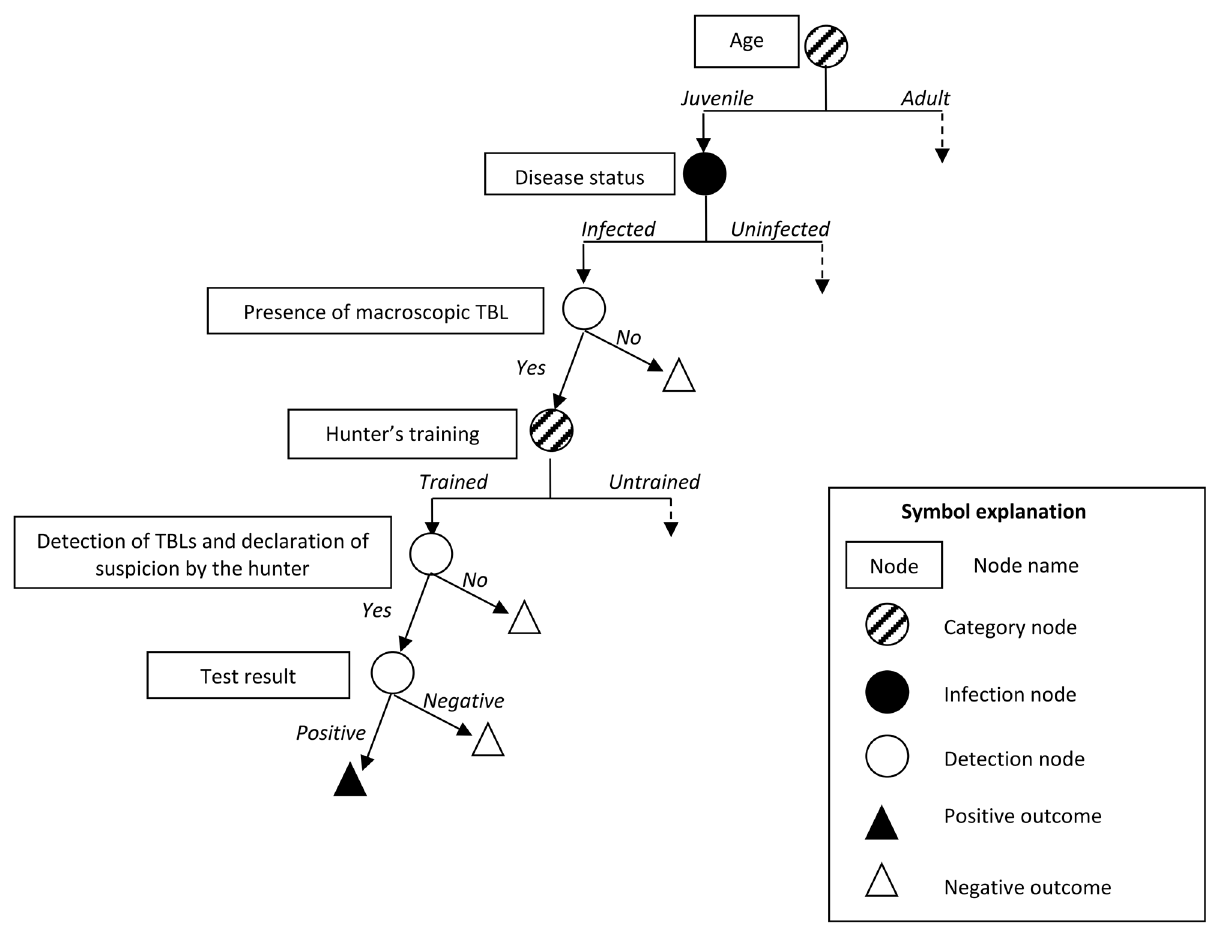
Fig 2. Scenario tree illustrating the scanning surveillance system component based on carcass examination for hunted wild boar, red deer and roe deer (EC-SSC, applied in areas of all risk levels).